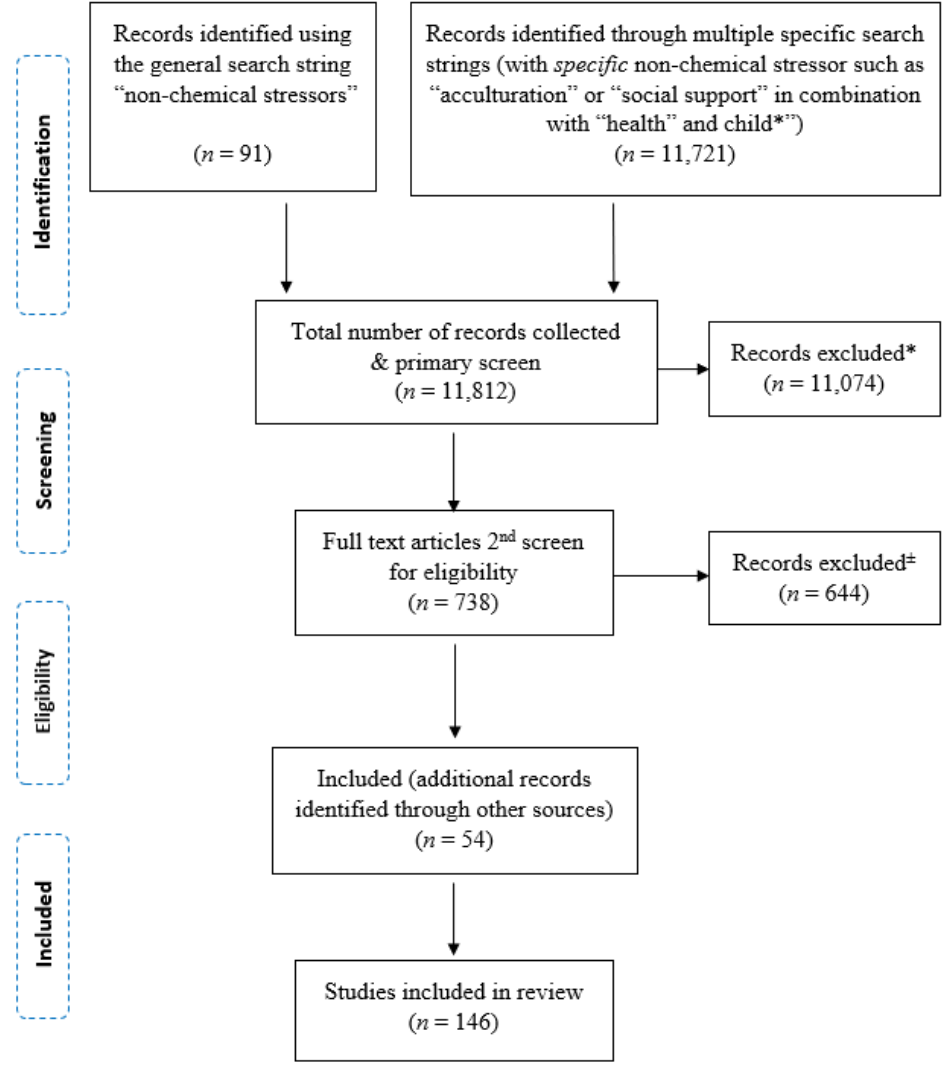
Figure 1. Diagram of record selection, eligibility, and inclusion; adapted from Preferred Reporting Items for Systematic Reviews and Meta-Analysis (PRISMA) [22] .